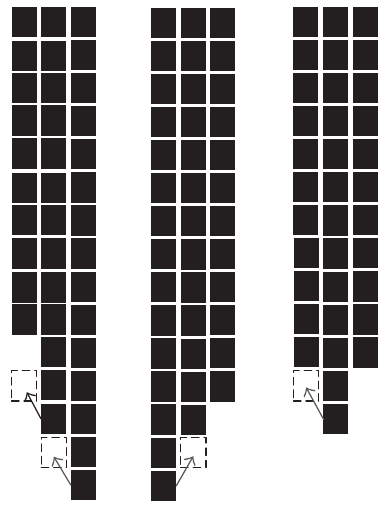
Figure 11: Chart showing passenger changing a